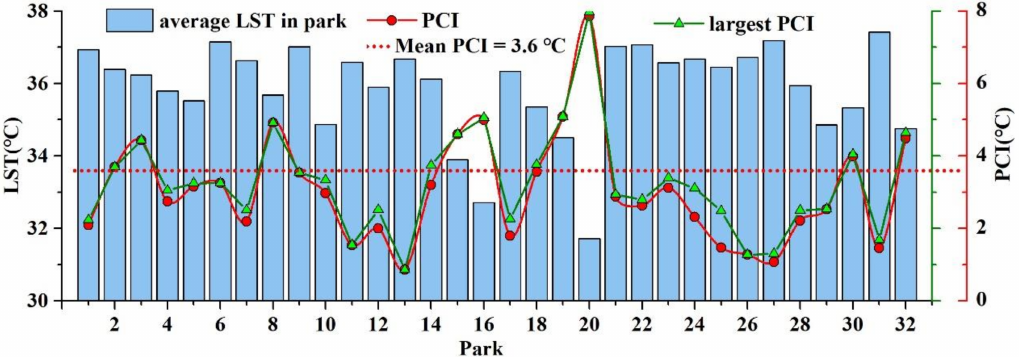
Figure 6. The internal LST of 32 urban parks and their